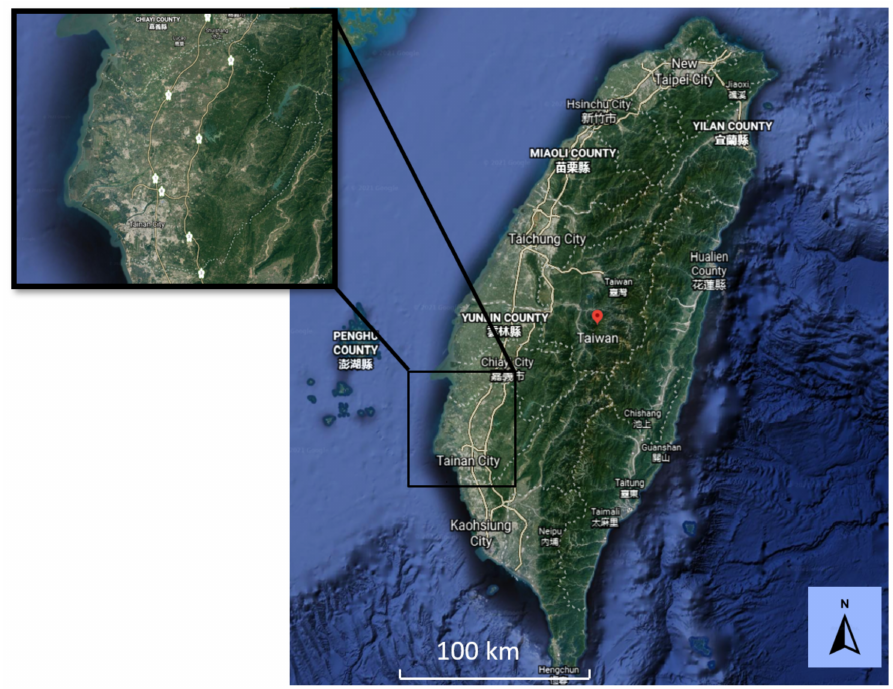
Figure 1. Map of Taiwan, Tainan (Google Earth Pro 7.3.3.7786